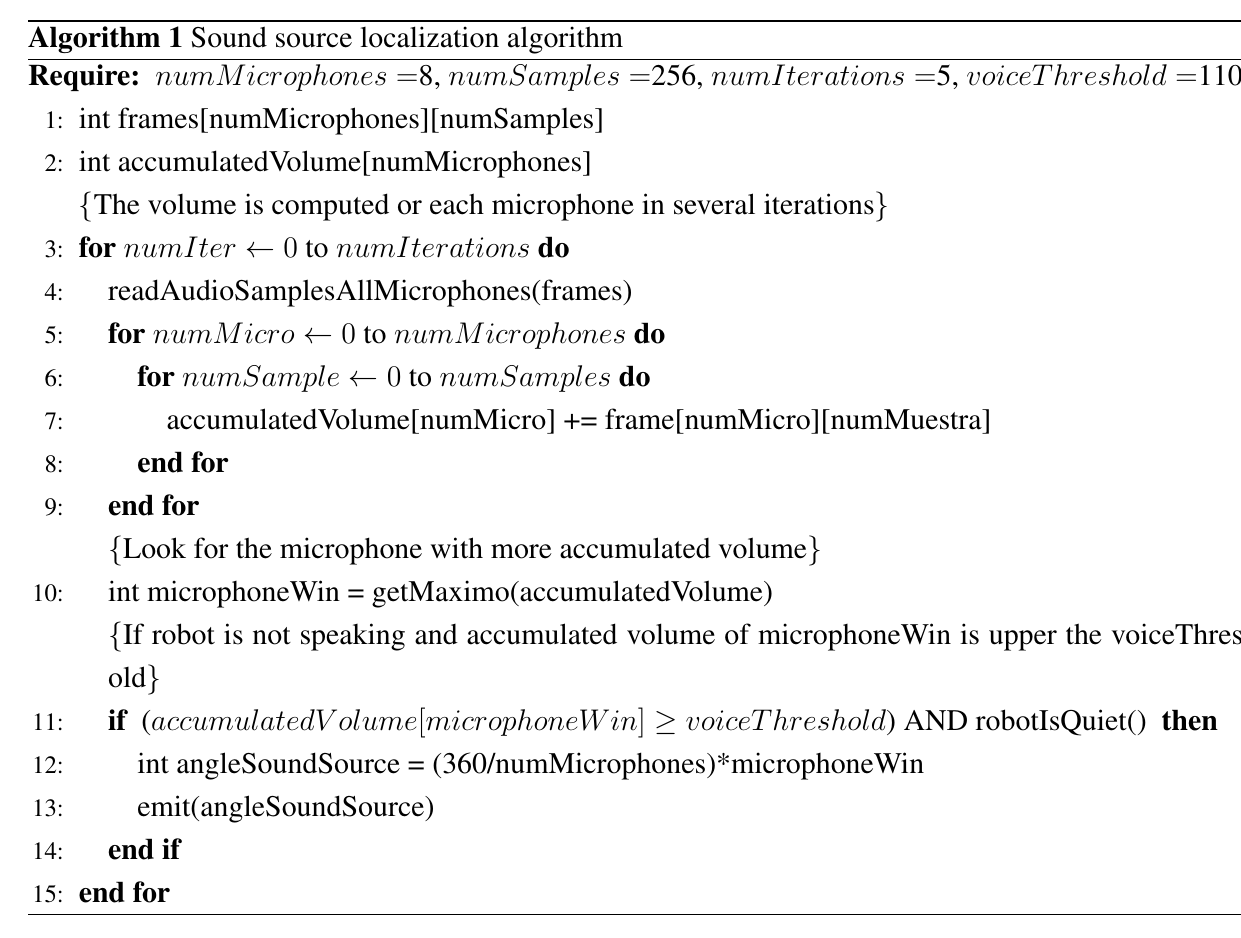
Algorithm 1 Sound source localization